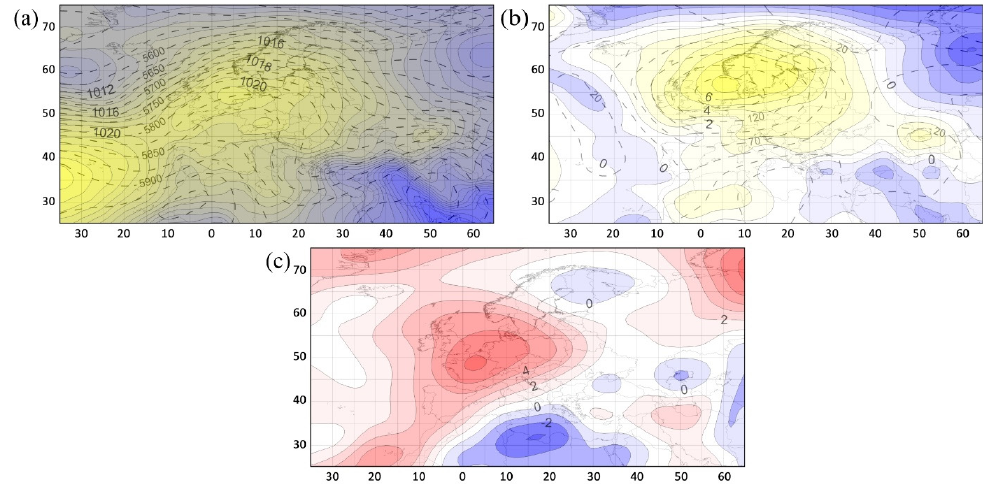
Figure 13. Composites of SLP in hPa (colour scale) and z500 hPa in gpm (dashed lines) ( a ); anomalies of SLP in hPa (colour scale) and z500 hPa in m (dashed lines) ( b ); anomalies of T850 in °C ( c ) for the HW of 10–28 July 2006.